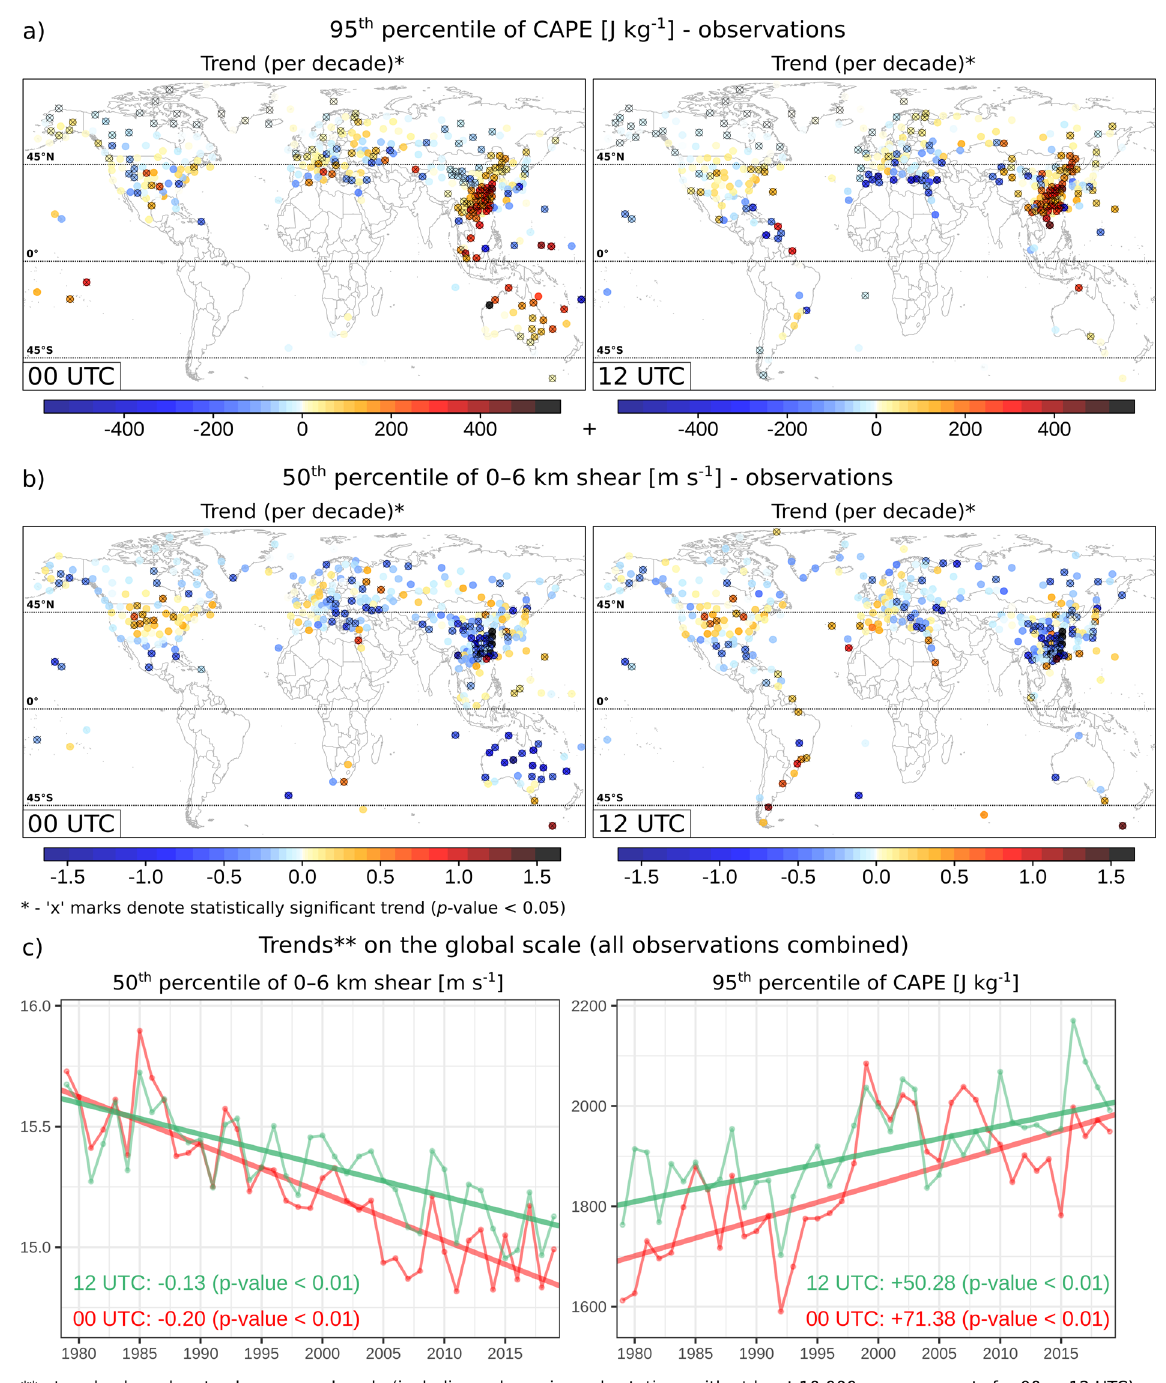
Fig. 5 Rawinsonde trends for CAPE and vertical wind shear. A 41-year (1979 – 2019) 0000 and 1200 UTC trends for ( a ) 95 th percentile of convective available potential energy (CAPE), and ( b ) 50 th percentile of 0 – 6 km vertical wind shear. Trends for all rawinsonde observations combined together are presented on ( c ). Trend is computed using Sen ’ s slope and value denote change per decade. Only stations that passed a rigorous quality-control procedure with at least 10000 observations available for 0000 or 1200 UTC (at least 100 per year over 30 years) are included in this